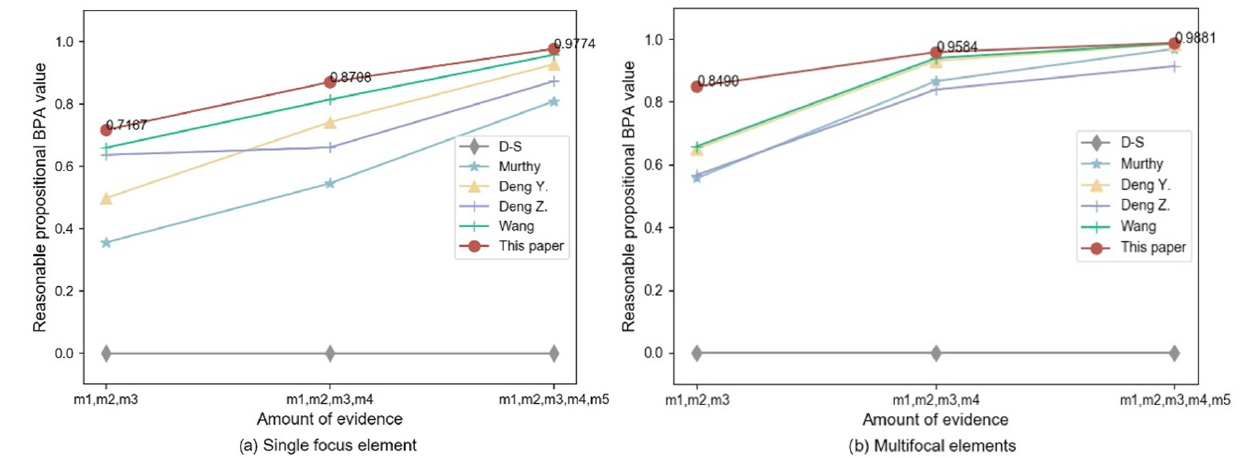
Figure 6. Comparison of the fusion results of multiple evidence. ( a ) Single focus element evidence fusion results. ( b ) Multi-focal element evidence fusion results.